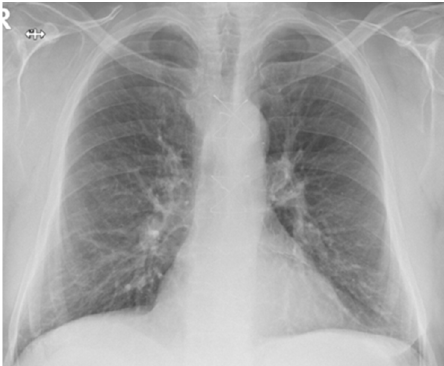
Figure 4. Chest X-Ray—2022—Case 1. Diffuse reticular opacities, especially in the basal regions.